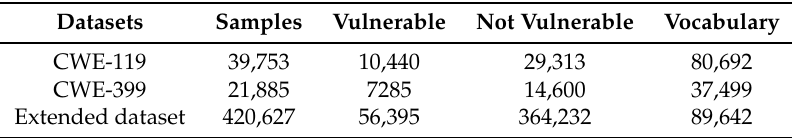
Table 1. Statistics on training data and pre-training data.